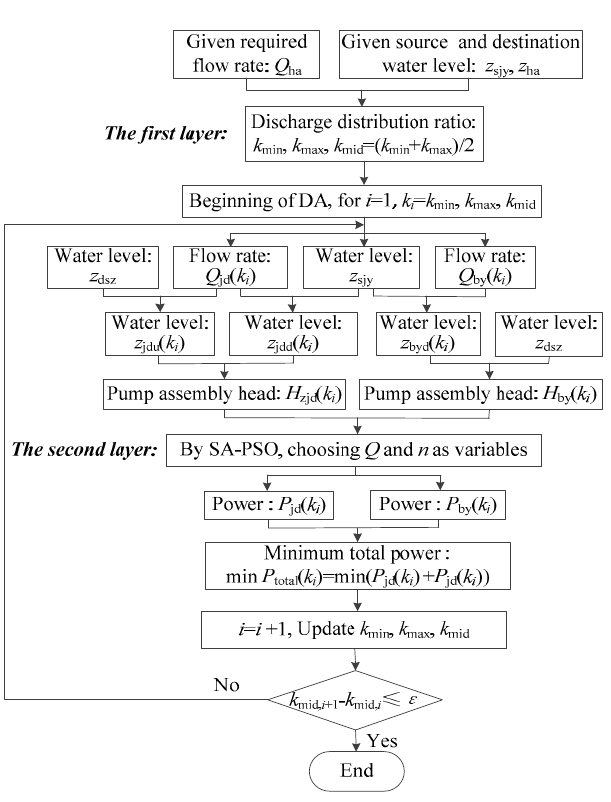
Figure 4. Schematic diagram of the hybrid algorithm.